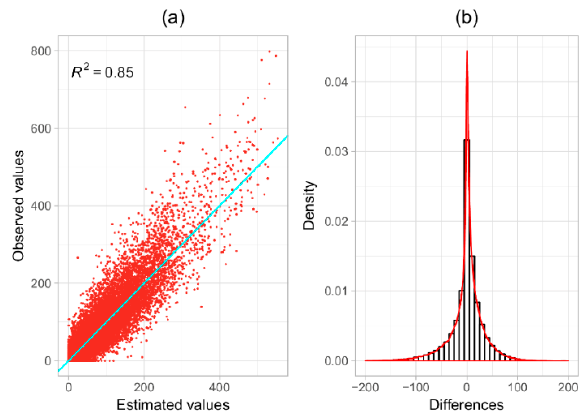
Figure 7. Comparison between the observed and estimated values ( a ) and the histogram of the di ff erence between these values ( b